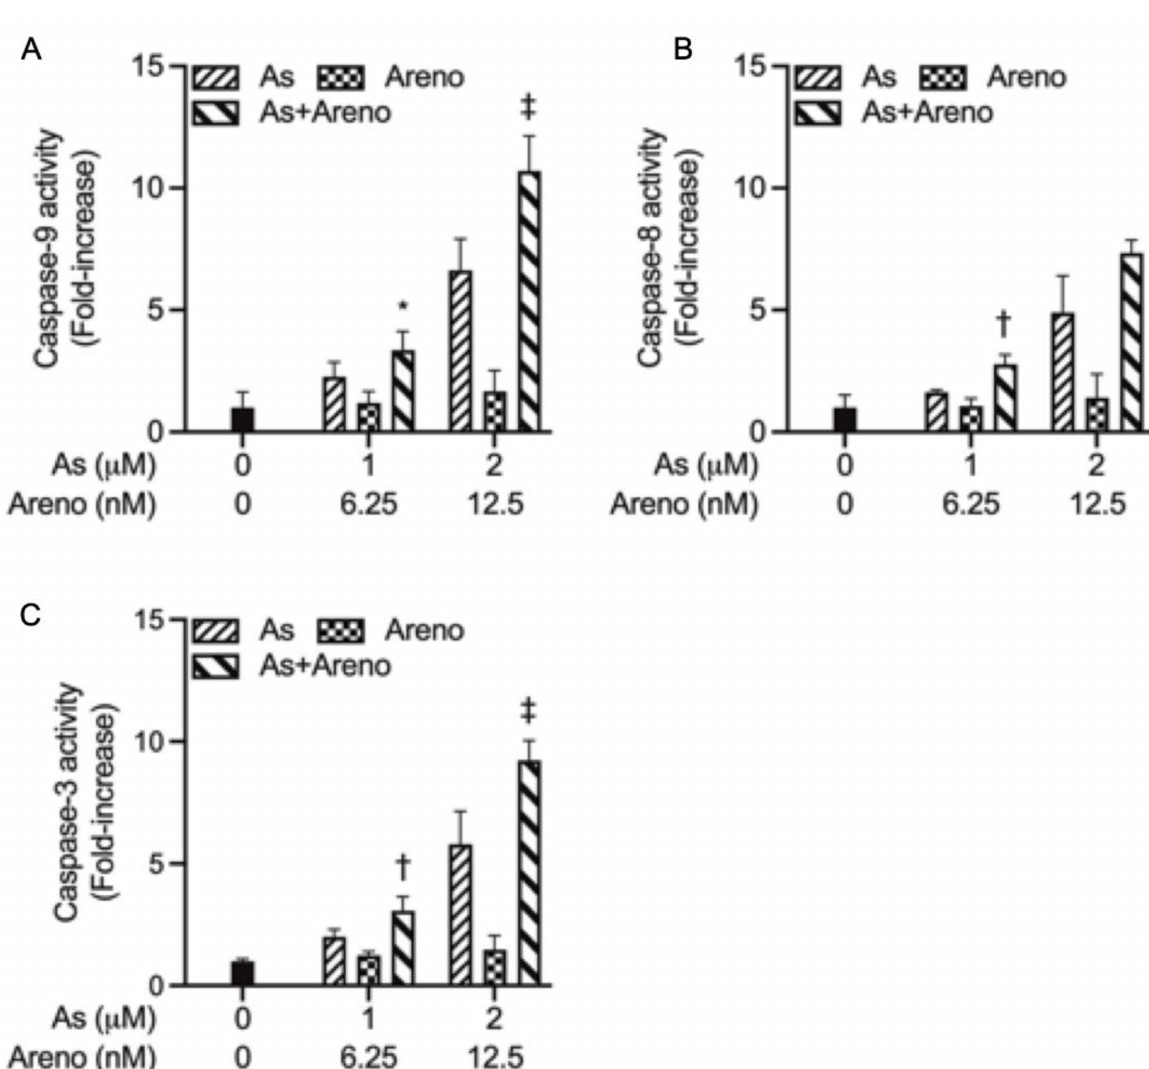
Figure 6. Caspases activation in U-87 cells treated with As III and arenobufagin, alone and in com- bination. Following treatment with As III (1, 2 µ M) and arenobufagin (6.25, 12.5 nM), alone and in combination, the activities of caspase-9 ( A ), -8 ( B ), and -3 ( C ) were measured using a caspase fluo- rometric assay kit, as described in “Materials and Methods”. Results are shown as the means ± SD from more than three independent experiments. *, p < 0.05; †, p < 0.01; ‡, p < 0.0001 vs. each alone. As, As III ; Areno;